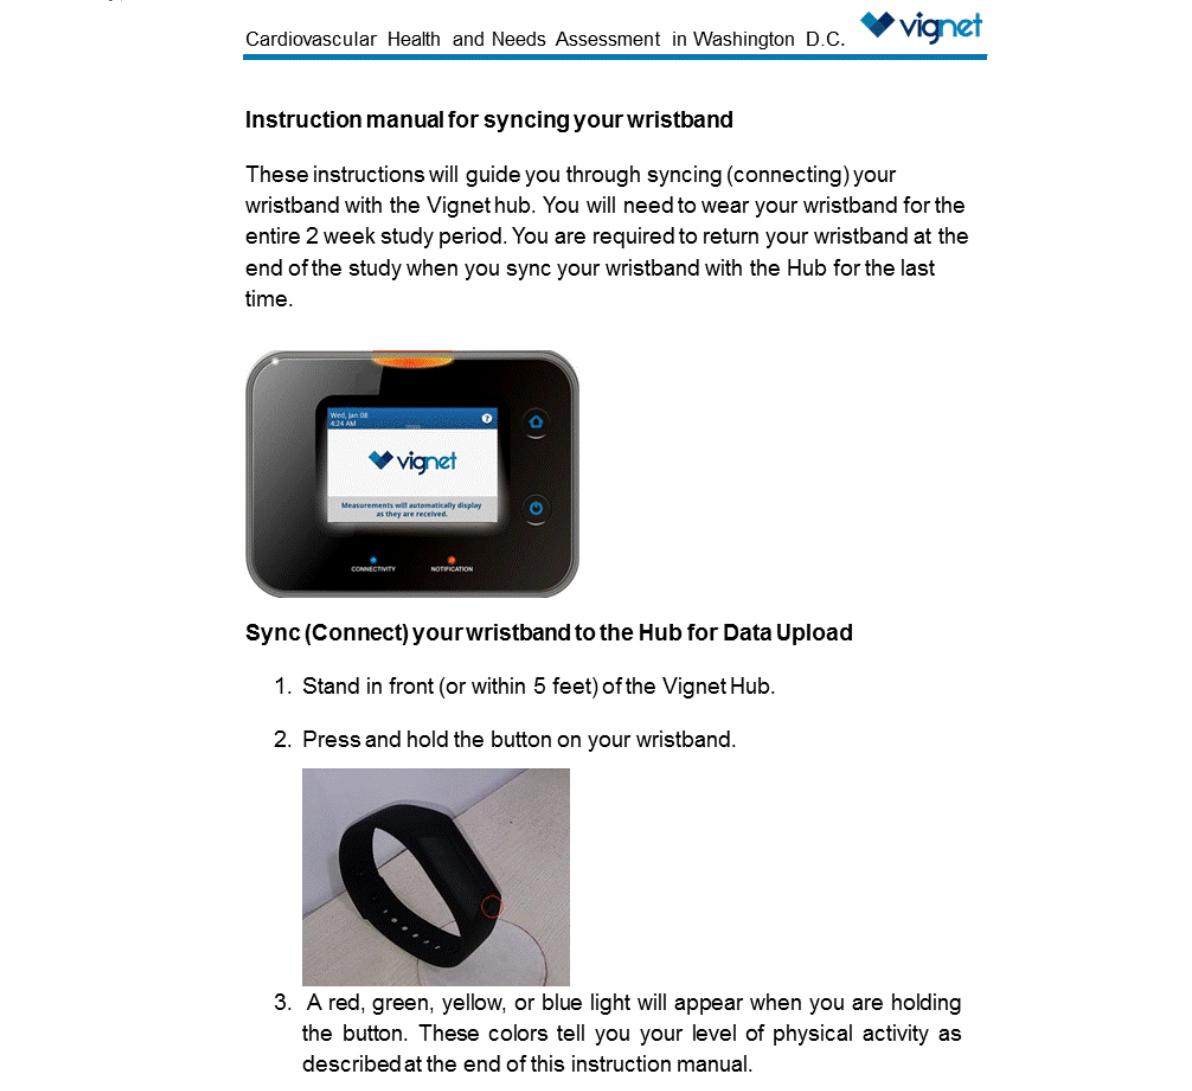
Figure 2. Instruction manual (page 1) for syncing physical activity-monitoring wristband with hub; Cardiovascular Health and Needs Assessment Qualitative Study,